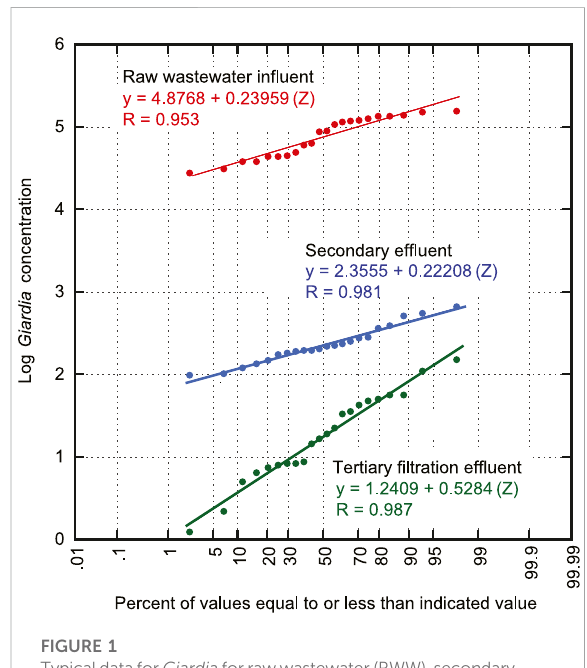
FIGURE 1 Typicaldatafor Giardia forrawwastewater(RWW),secondary biological treatment ef fl uent (SE), and tertiary fi ltration ef fl uent (TE).